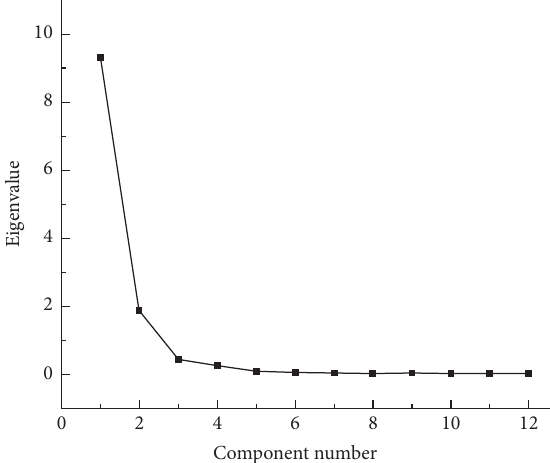
Figure 2: Analysis of the scree plot of principal